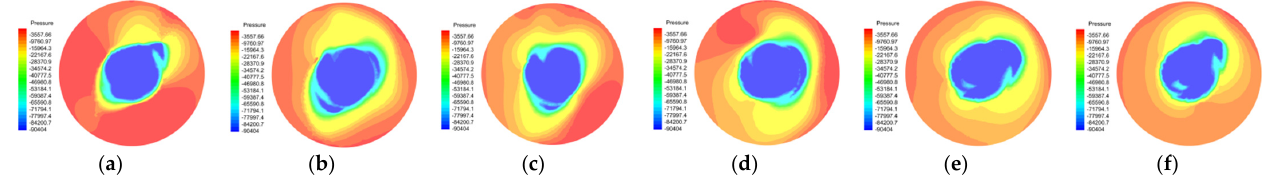
Figure 16. When inlet pressure = 15 MPa, gap = 1.5 mm, the variation of pressure of the original suction cup with time in adhesion interface plane at: ( a ) 5 ms, ( b ) 9.4 ms, ( c ) 13.8 ms, ( d ) 18.2 ms, ( e ) 22.6 ms, and ( f ) 27 ms.